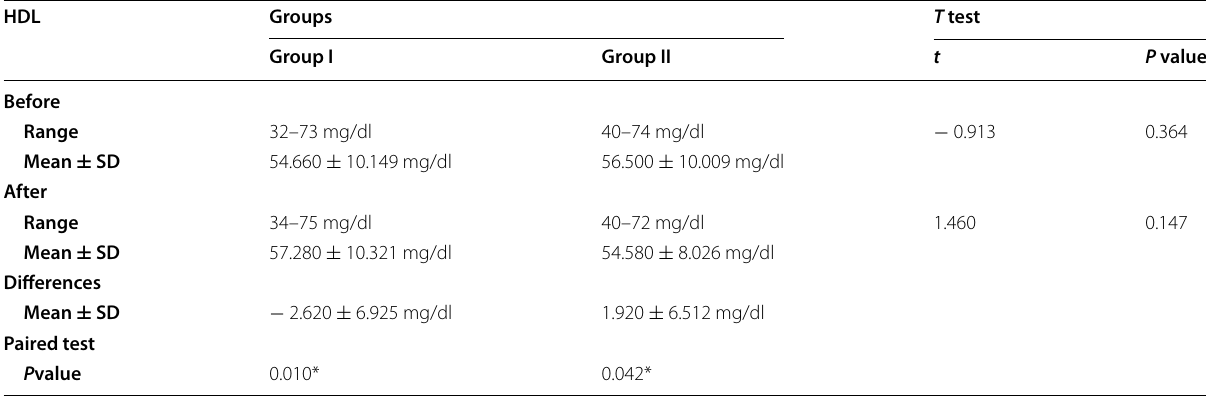
t Student’s t test, p p value for comparing between the two groups